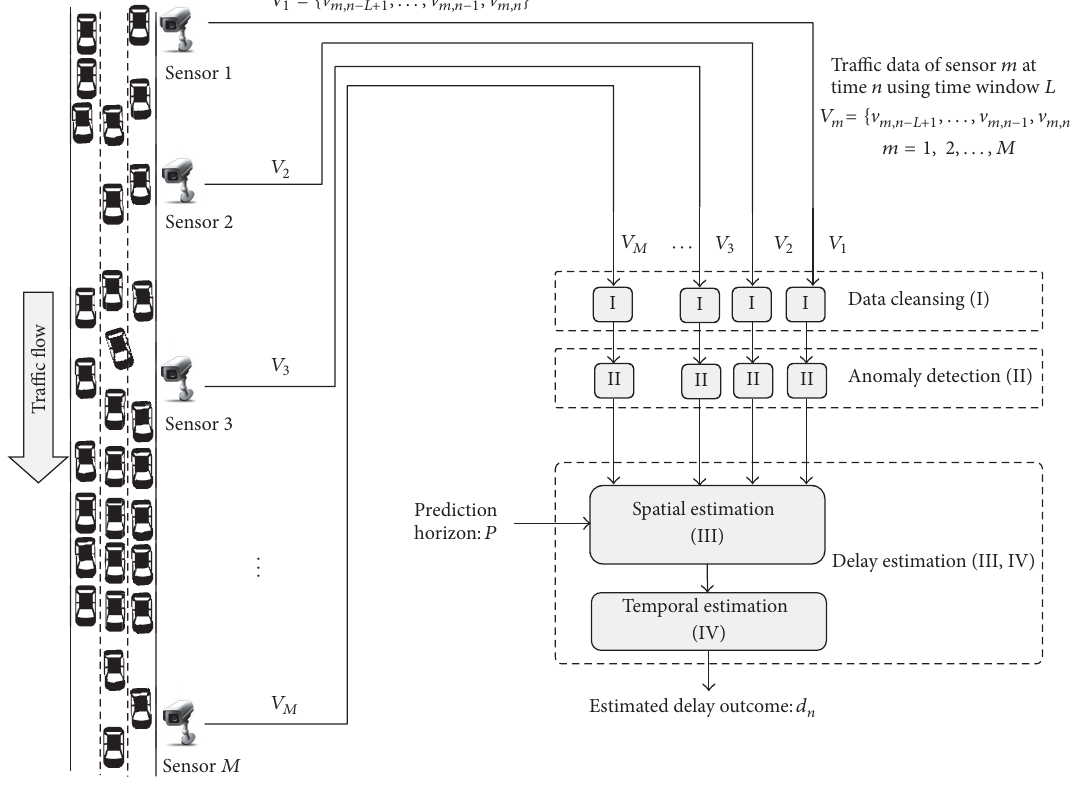
Figure 2: Overview of the proposed algorithm.